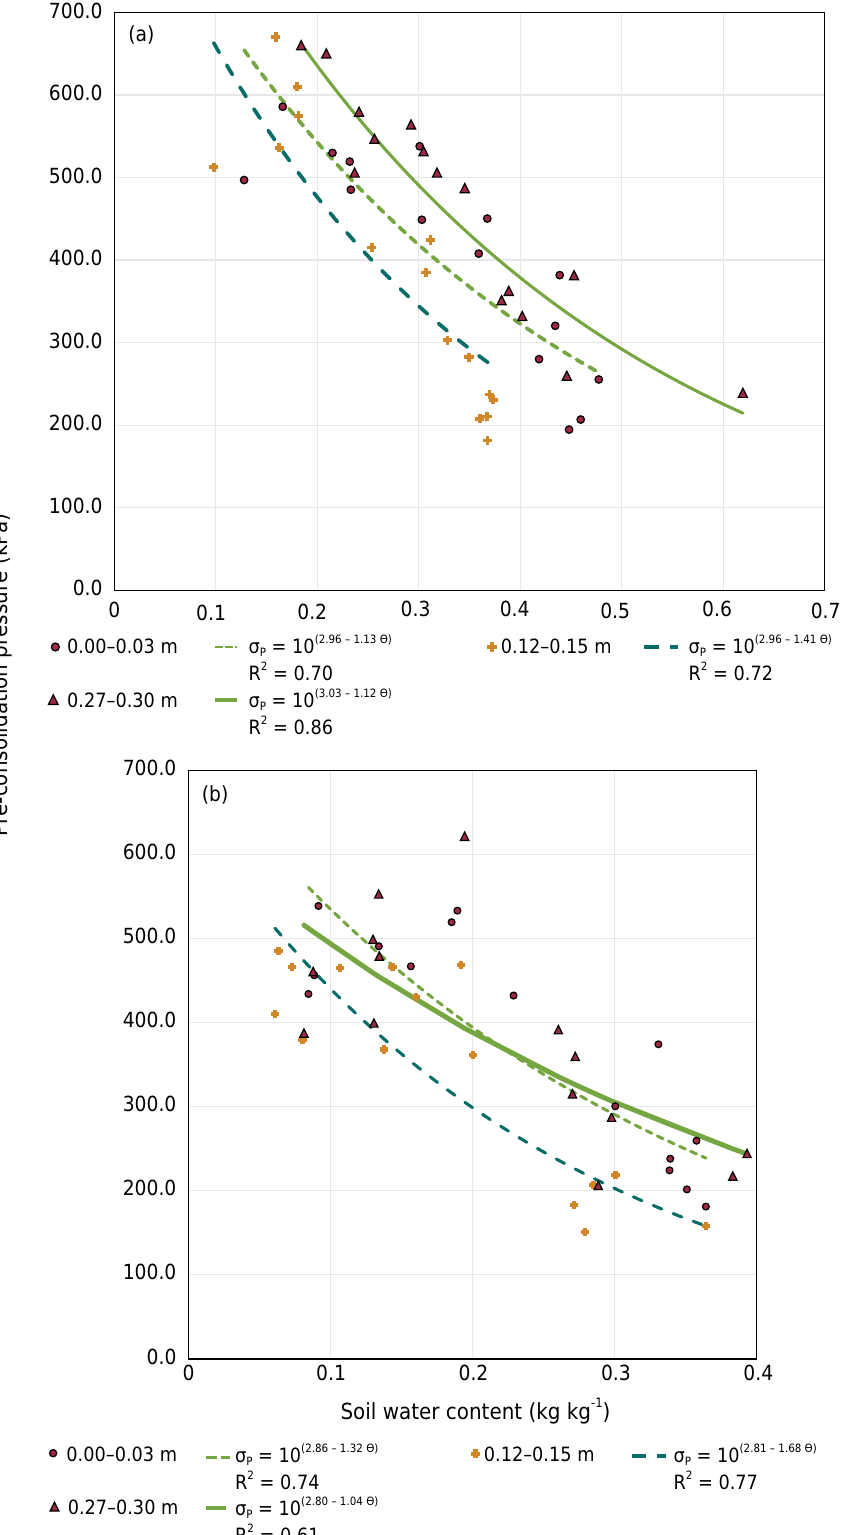
Figure 2. Soil load-bearing capacity models for coffee plantations under full sun (a) and shaded (b) management